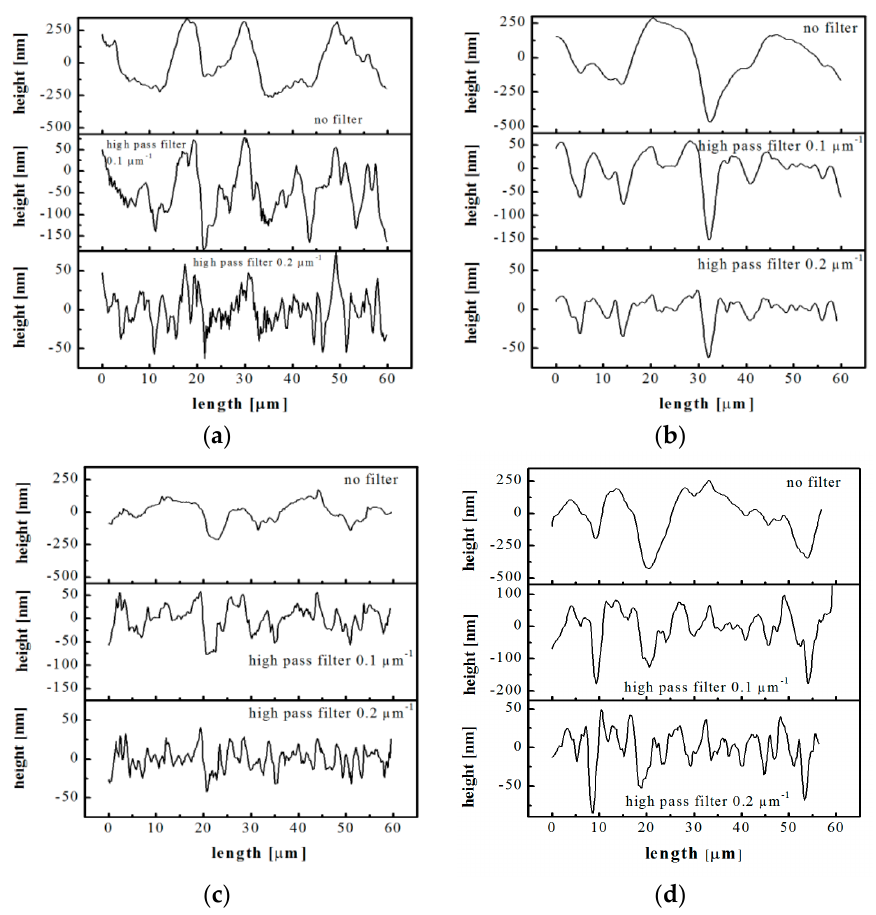
Figure 6. AFM patterns obtained from the maps acquired on the ( a ) steel layer; ( b ) CIM sample (20 mm distance from the gate); ( c ) 160-18 sample (20 mm distance from the gate) and ( d ) 160-18 sample (50 mm distance from the gate). Three patterns are reported for each sample: the flattened pattern, and the patterns obtained applying 0.1 and 0.2 μ m − 1 high pass filters.